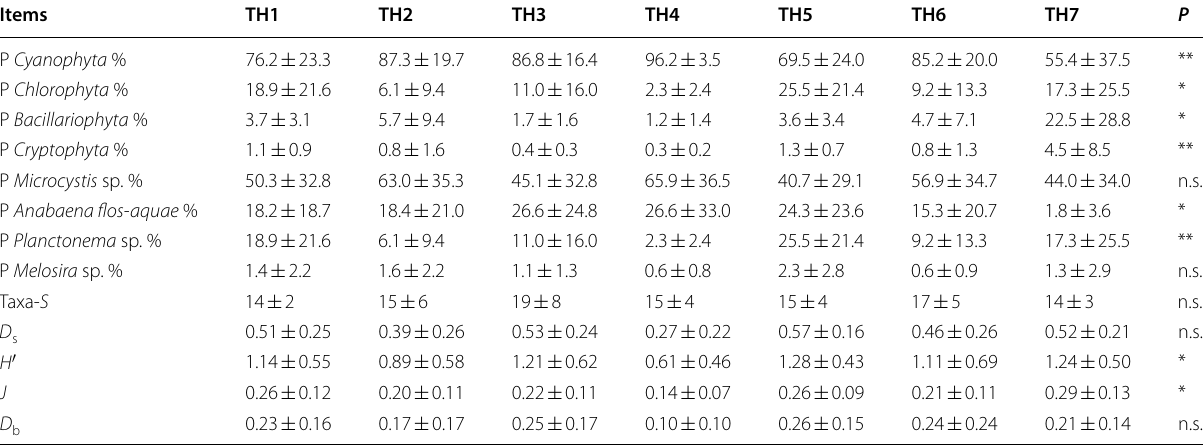
P Cyanophyta : percent of Cyanophyta density among the phytoplankton community; P Chlorophyta : percent of Chlorophyta density among the phytoplankton community; P Bacillariophyta : percent of Bacillariophyta density among the phytoplankton community; P Cryptophyta : percent of Cryptophyta density among the phytoplankton community; P Microcystis sp.: percent of Microcystis sp. density among the phytoplankton